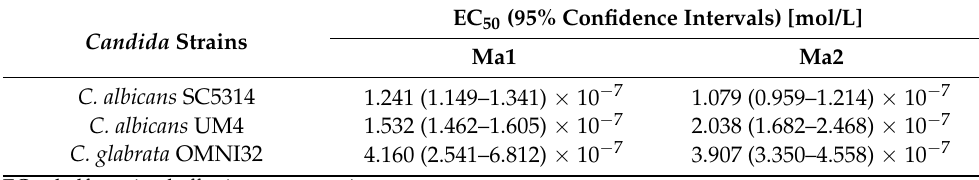
Table 1. In vitro anti- Candida activity of Ma1 and Ma2 peptides against planktonic cells.